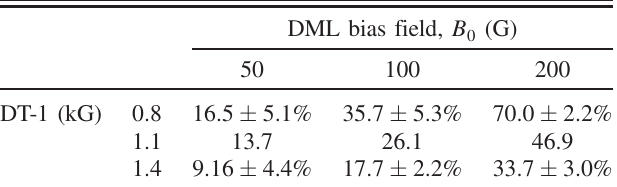
TABLE V. Average excluded flux (nV s).